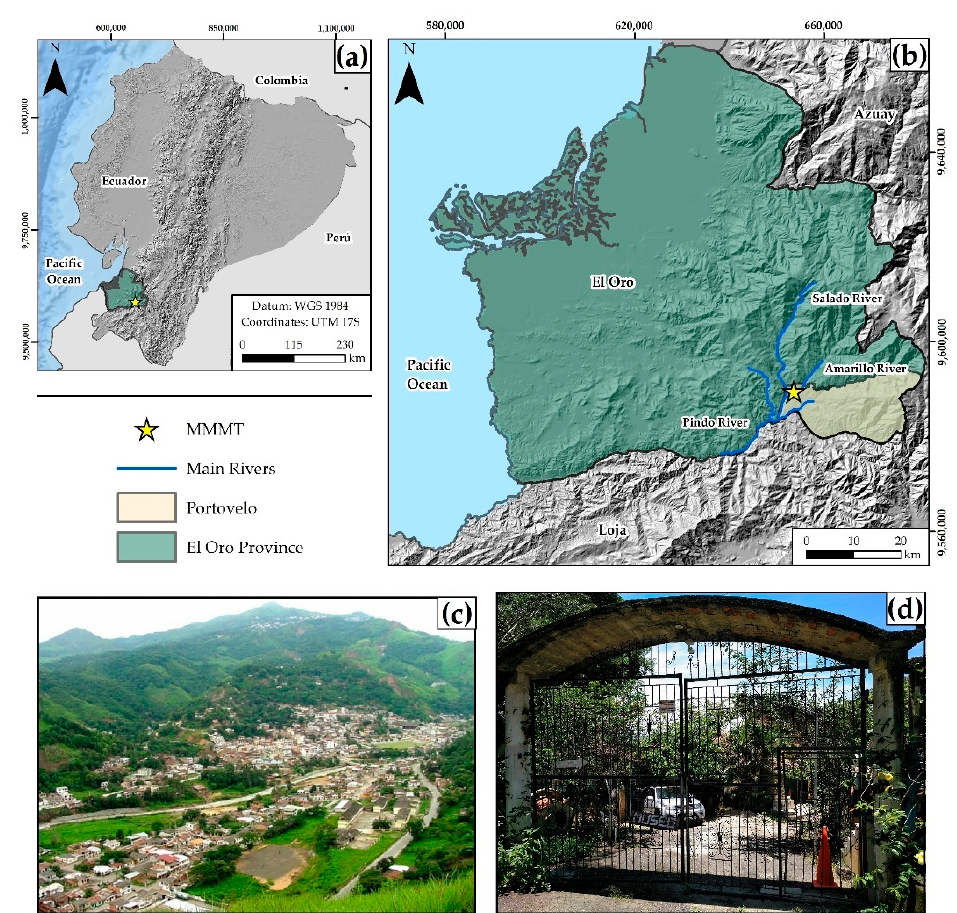
Figure 1. ( a , b ) Study area location. ( c ) Panoramic view of Portovelo city. ( d ) Museo Mineralógico Magner Turner.